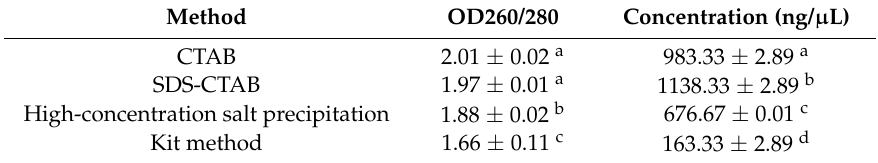
Figure 1. The effect of different DNA extraction methods. ( A ) The electrophoresis profile of T. matsutake genomic DNA; ( B ) the digestion result of T. matsutake genomic DNA. 1–2: cetyltrimethyl ammonium bromide (CTAB); 3–4: SDS-CTAB; 5–6: high-salt enzymolysis; 7–8: fungal genomic DNA isolation kit; M: DNA marker DL 2000; ( C ) the electrophoresis profile of PCR products of Tricholoma matsutake genomic DNA amplified by 18S universal primers. 1: negative control; 2–3: CTAB; 4–5: SDS-CTAB; 6–7: